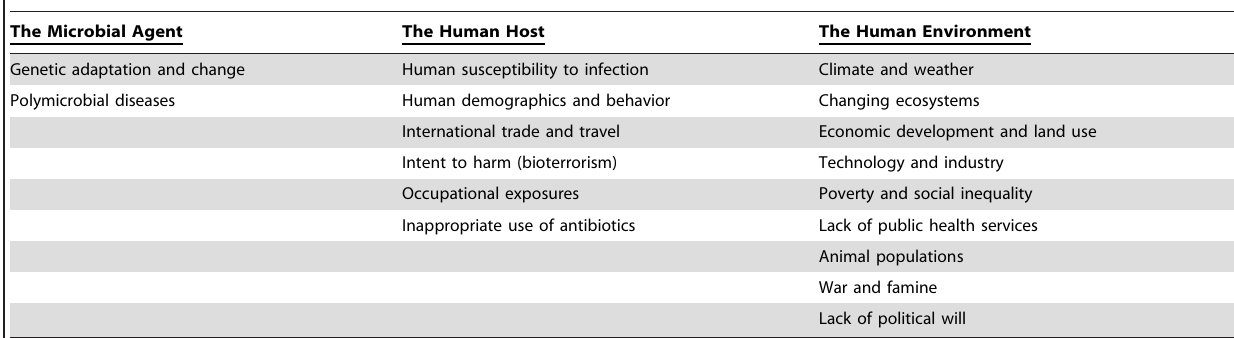
Table 1. Some major factors that underlie disease emergence and reemergence [2,5].